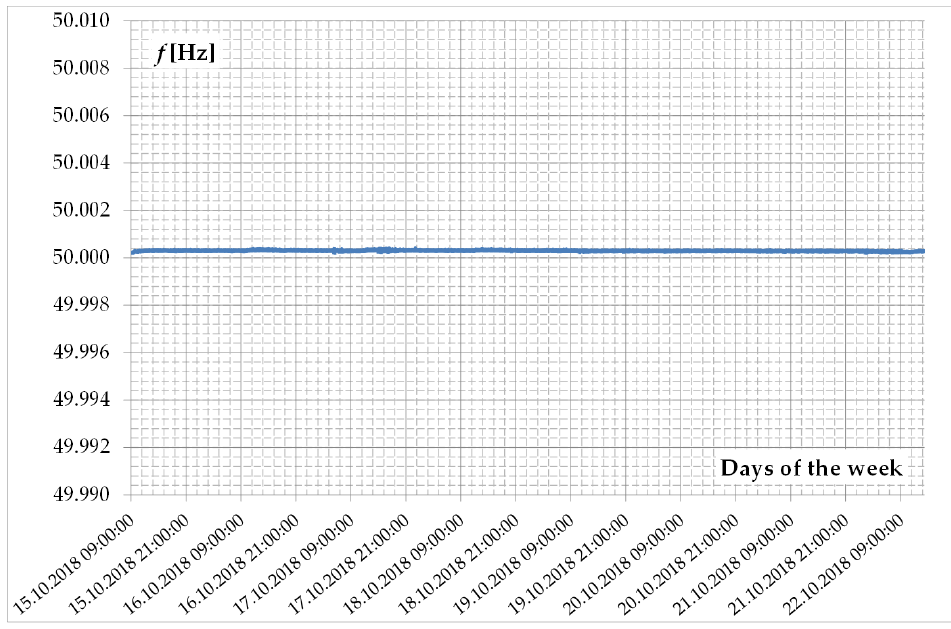
Figure 18. Frequency waveforms of the supply voltage during the